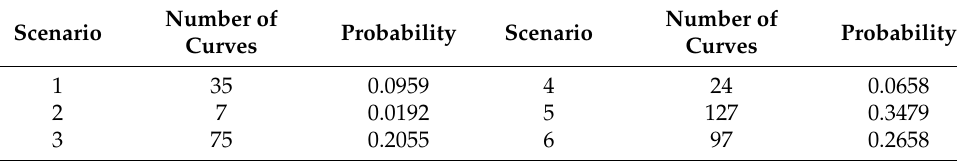
Table 1. Typical scenario